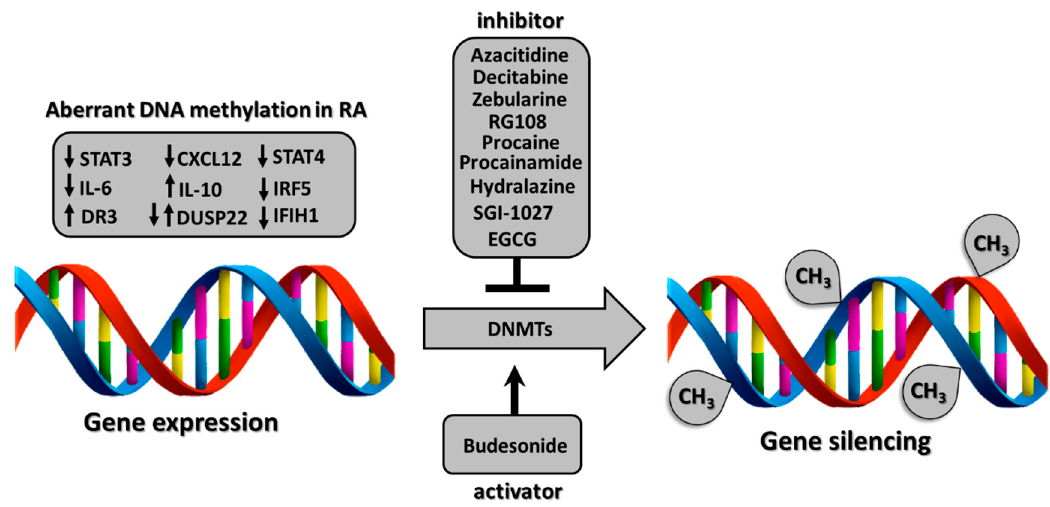
Figure 2. Potential mechanism of differentially methylated genes in rheumatoid arthritis (RA) regulated by various epigenetic drugs. DNA methylation is exerted by DNMTs. DNMTs are influenced by various epigenetic drugs either inhibiting or activating DNMTs, which consequently results in modulation of gene expression. Down arrow indicates hypomethylated genes ( STA3, IL-6, CXCL12, DUSP22, STAT4, IRF5, IFIH1 ), and up arrow indicates hypermethylated genes ( DR3, IL-10, DUSP22 ) in RA.